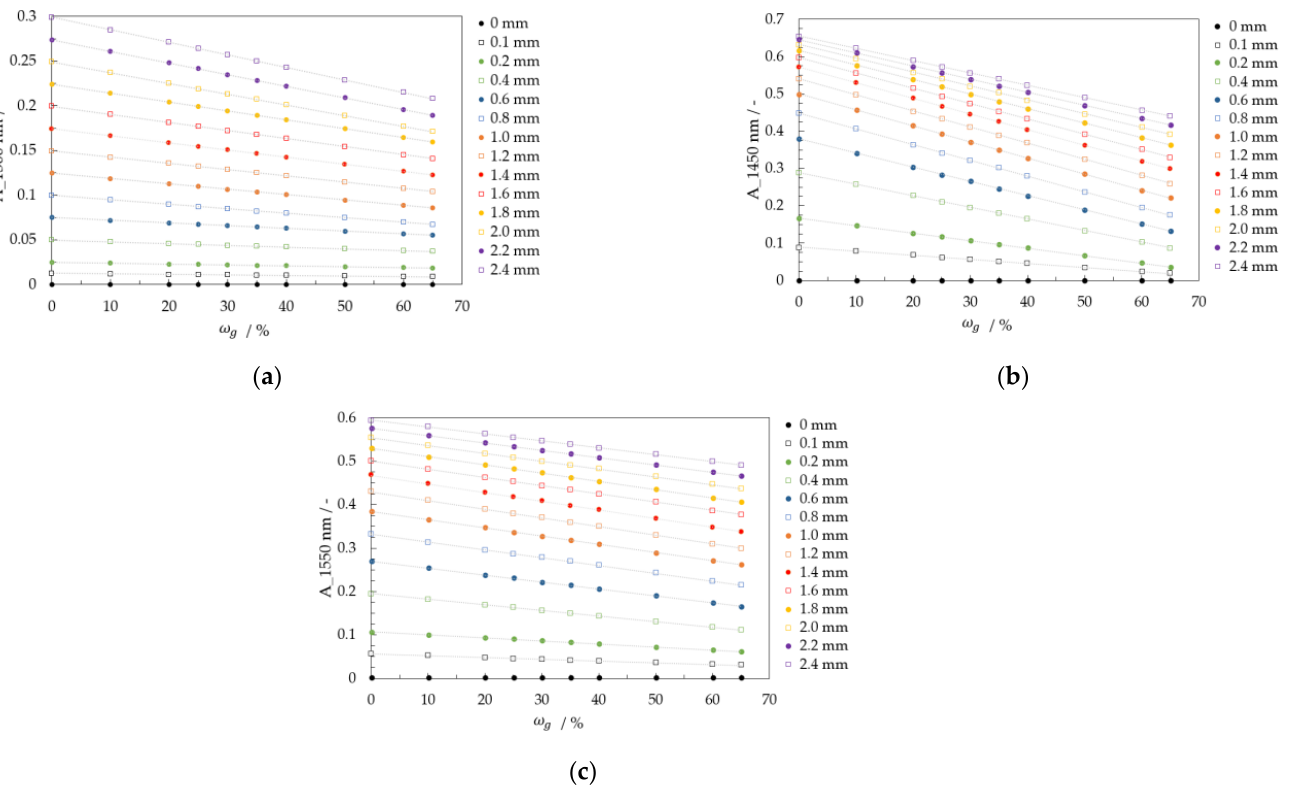
Figure 8. Calibration curves with the NIR technique for the glycerol/water mixture from 𝜔 𝑔 = 0 to 0.65 𝑔 𝑔𝑙𝑦𝑐 𝑔 𝑡𝑜𝑡𝑎𝑙−1 ( a ) 1300 nm ( b ) 1450 nm and ( c ) 1550 nm .